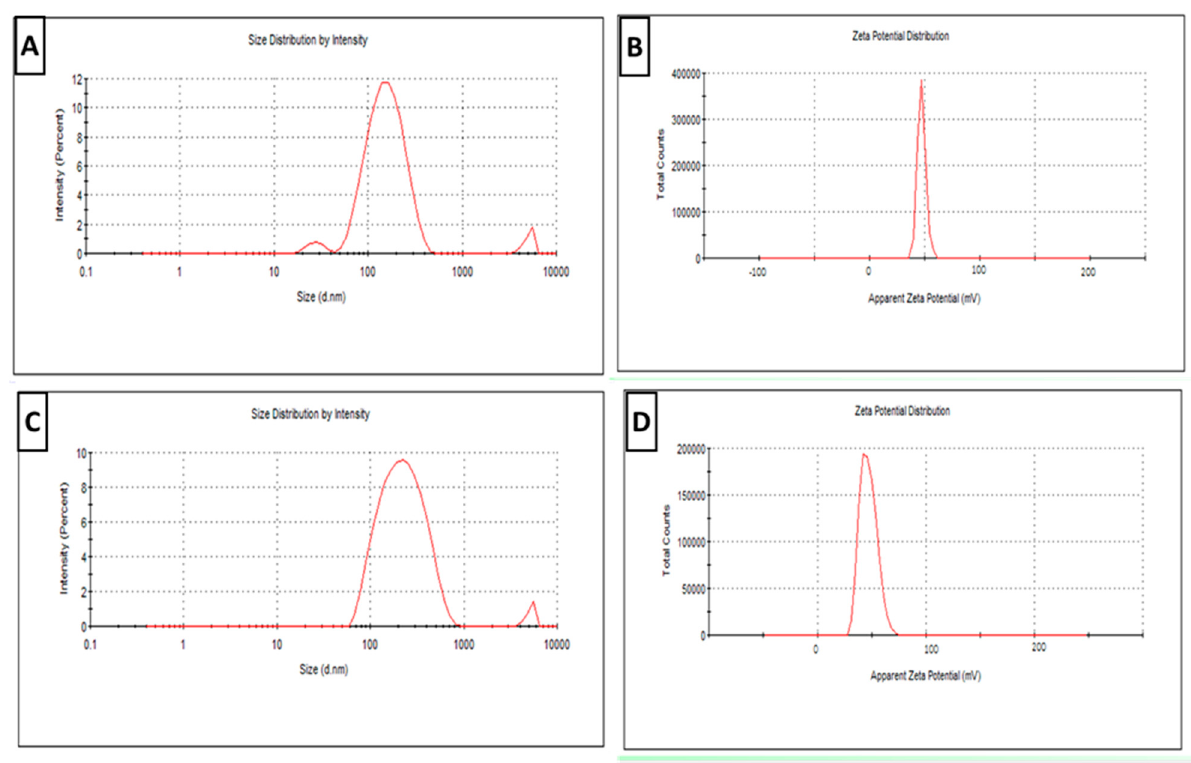
Figure 1. Physical characterization of newly prepared plain and RA-SLN dispersions (zero day). ( A ) The particle size distribution curve for plain SLNs. ( B ) The plain SLNs’ ZP curve. ( C ) The RA-SLN particle size distribution curve. ( D ) The RA-SLNs’ ZP curve.